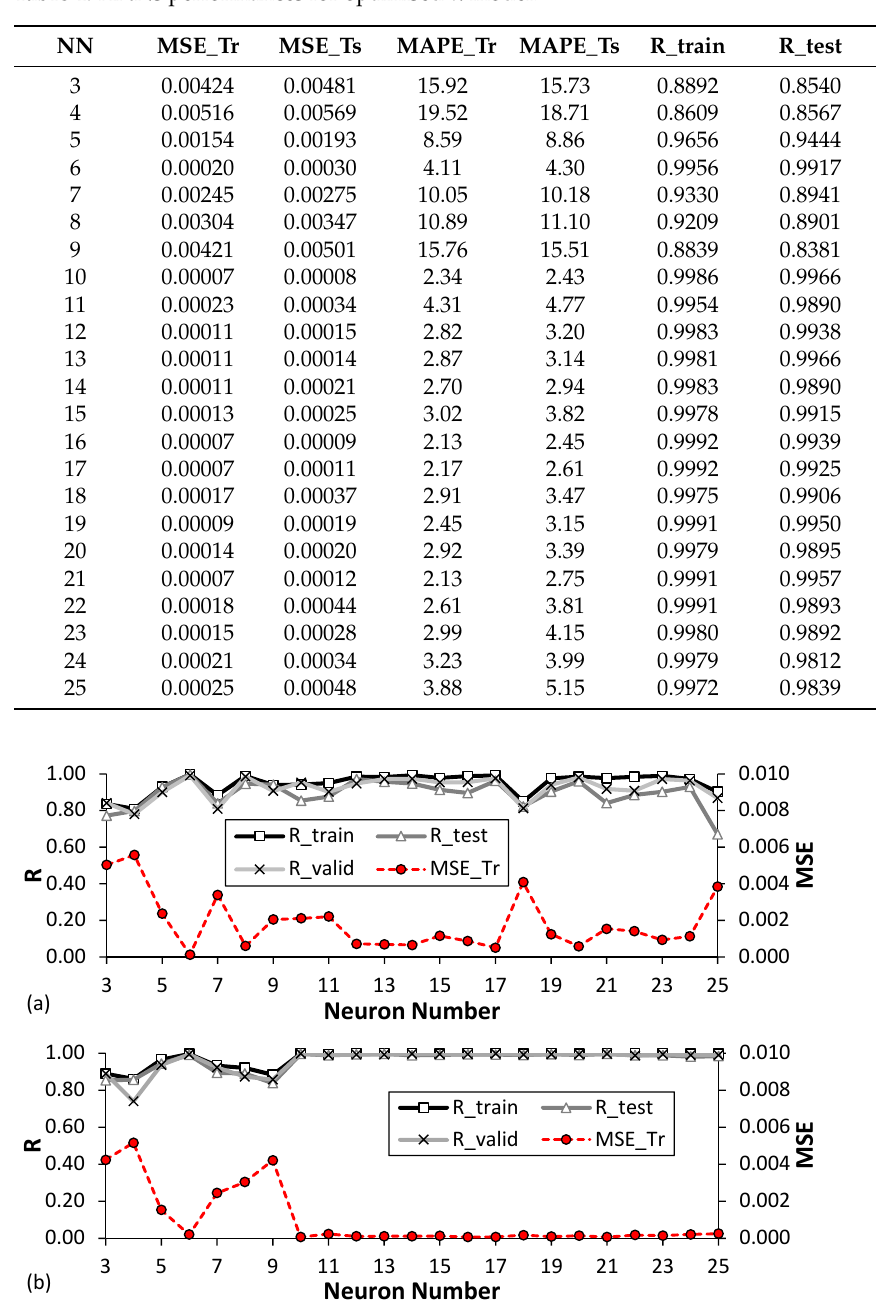
Table 4. ANNs performances for optimised α model.